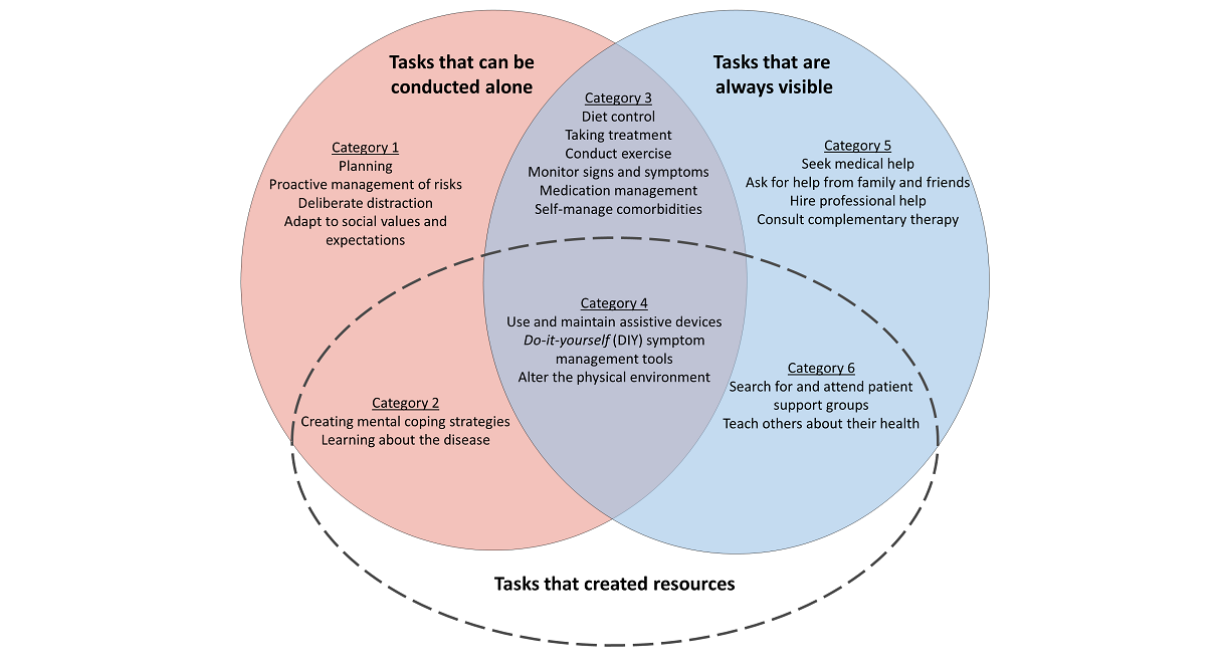
Figure 2. Patient work tasks were categorized according to their alignment along the 3 axes of collaboration, visibility, and creating